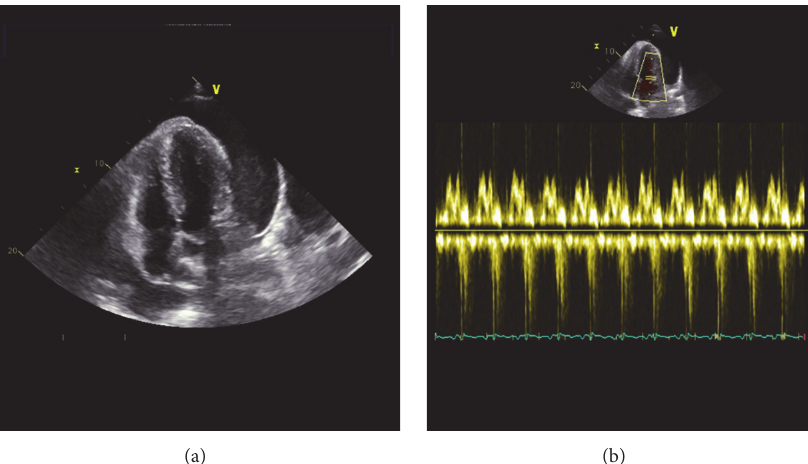
Figure 3: Echocardiogram shows significant pericardial effusion (a) without significant impact on right ventricular function proved by normal mitral inflow